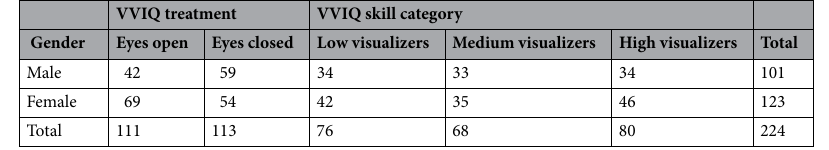
Table 3. VVIQ categories.